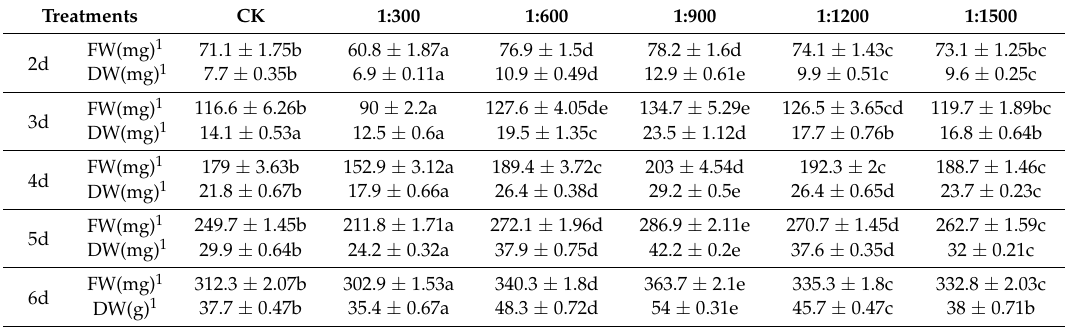
Figure 1. Phenotypic changes in wheat plants following seed soaking treatments with different concentrations of wood vinegar (WV). The various concentrations include 0 ( A , CK group), 1:300, 1:600, Table 1. Effect of different concentrations of wood vinegar on the fresh weight (FW) and dry weight (DW) of shoots of five wheat seedlings.